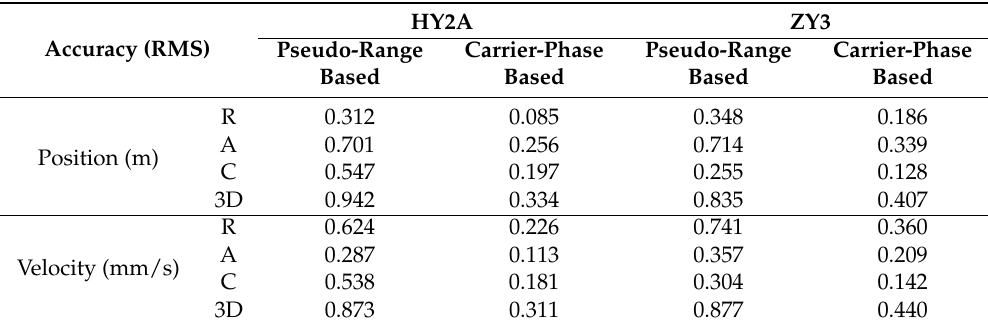
Table 3. The overall statistics of real-time orbit